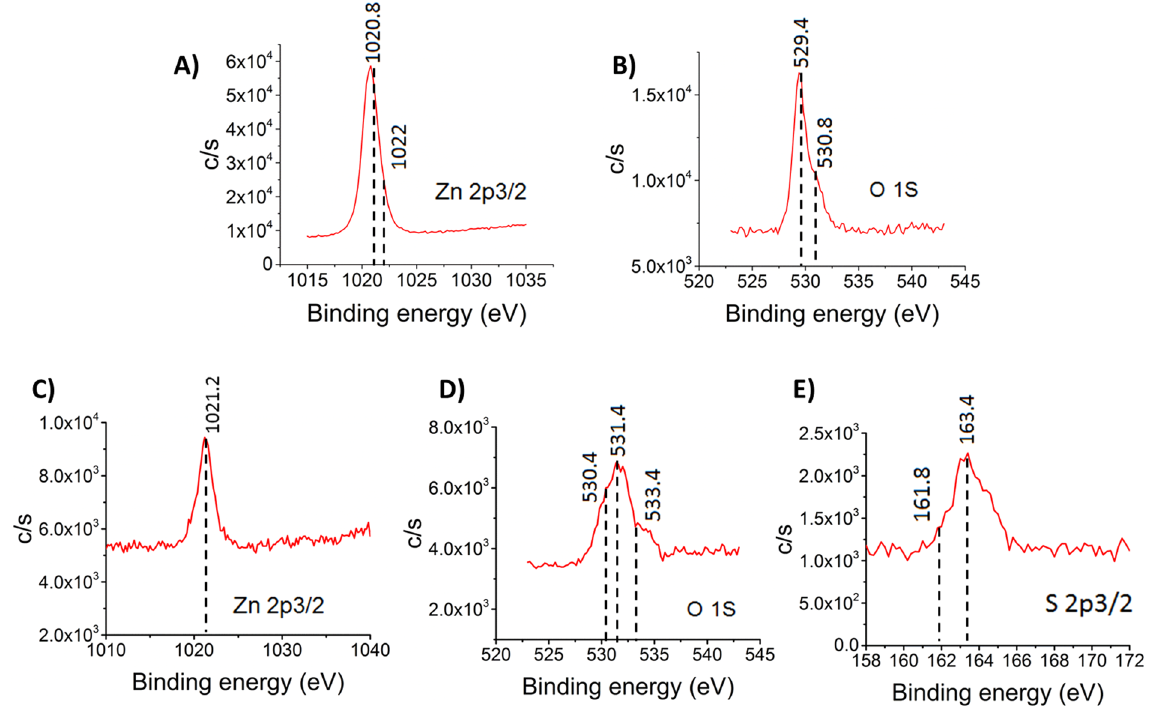
Figure 3. XPS plots of ( A ) Zn 2p 3/2 peak ( B ) O 1 s peak in bare ZnO and ( C ) Zn 2p 3/2 peak ( D ) O 1 s peak ( E ) S 2p 3/2 peak in DSP functionalized ZnO